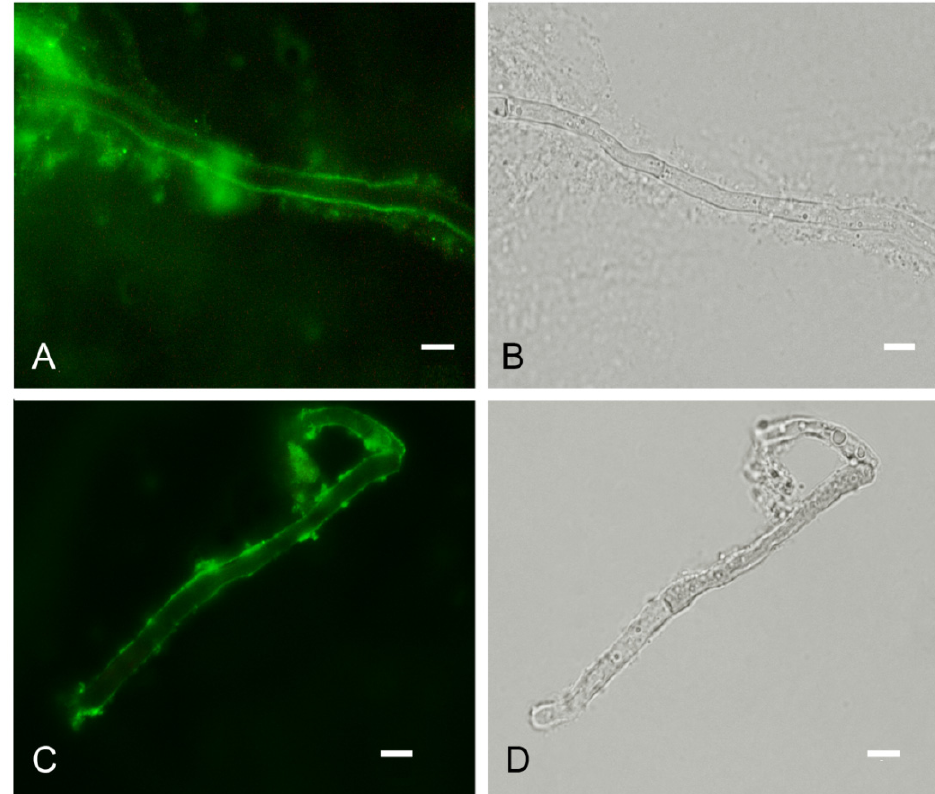
Figure 6. Melanin-specific MAb 8D6 labels the cell walls of septate hyphae in corneal exudate obtained from a patient with culture-negative fungal keratitis. Corresponding immunofluorescence ( A ) and bright-field ( B ) images demonstrating the labelling of the cell walls of septate hyphae by the MAb in cornea scraping. Corresponding immunofluorescence ( C ) and bright-field ( D ) images showing melanin particles recovered from corneal sample labeled with MAb 8D6. Bars, 5 µ m.